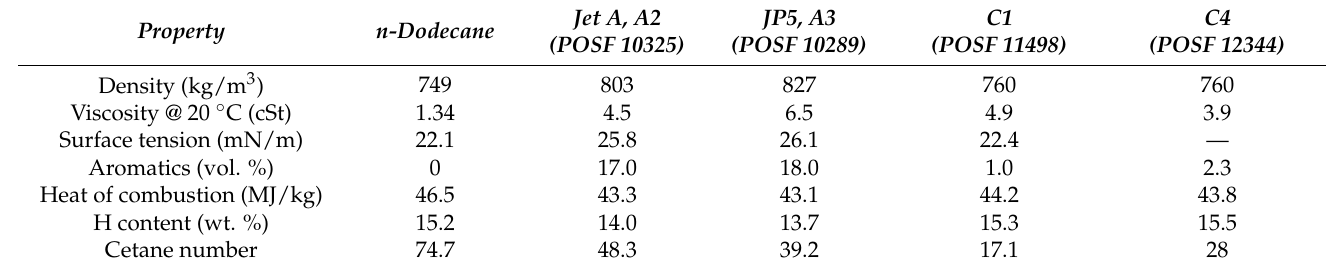
Table 1. Main thermophysical properties of selected Category A and C fuels